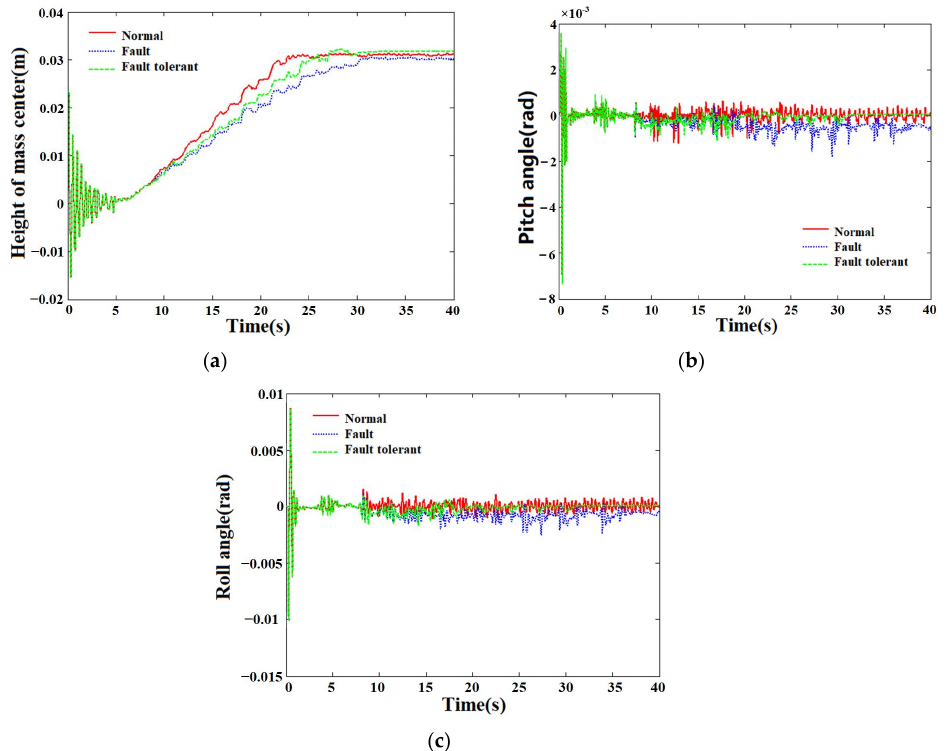
Figure 14. Performance comparison before and after fault tolerant control under Fault 2: ( a ) Relative height of mass center; ( b ) Pitch angle; ( c ) Roll angle.